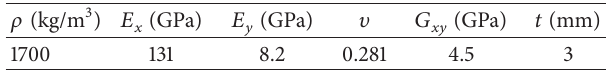
Table 1: Material properties of a composite plate: mass density ( 𝜌 ), Young’s modulus ( 𝐸 ), shear modulus ( 𝐺 ), Poisson coefficient ( 𝜐 ), and thickness ( 𝑡